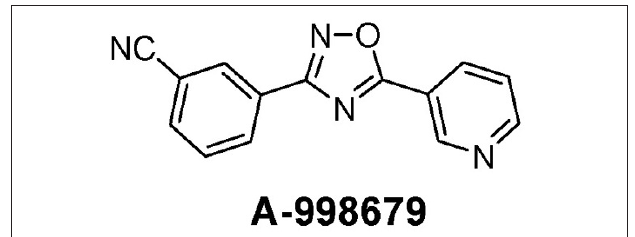
FIGURE 1 | Chemical structure of